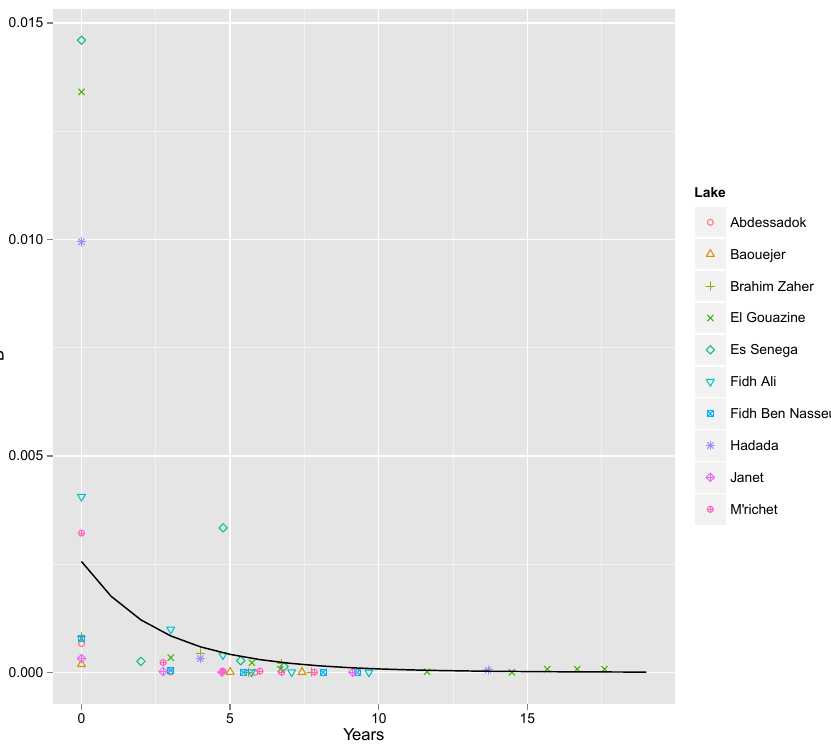
Figure 9. Modelled evolution (black line) of the B and β parameters over time.